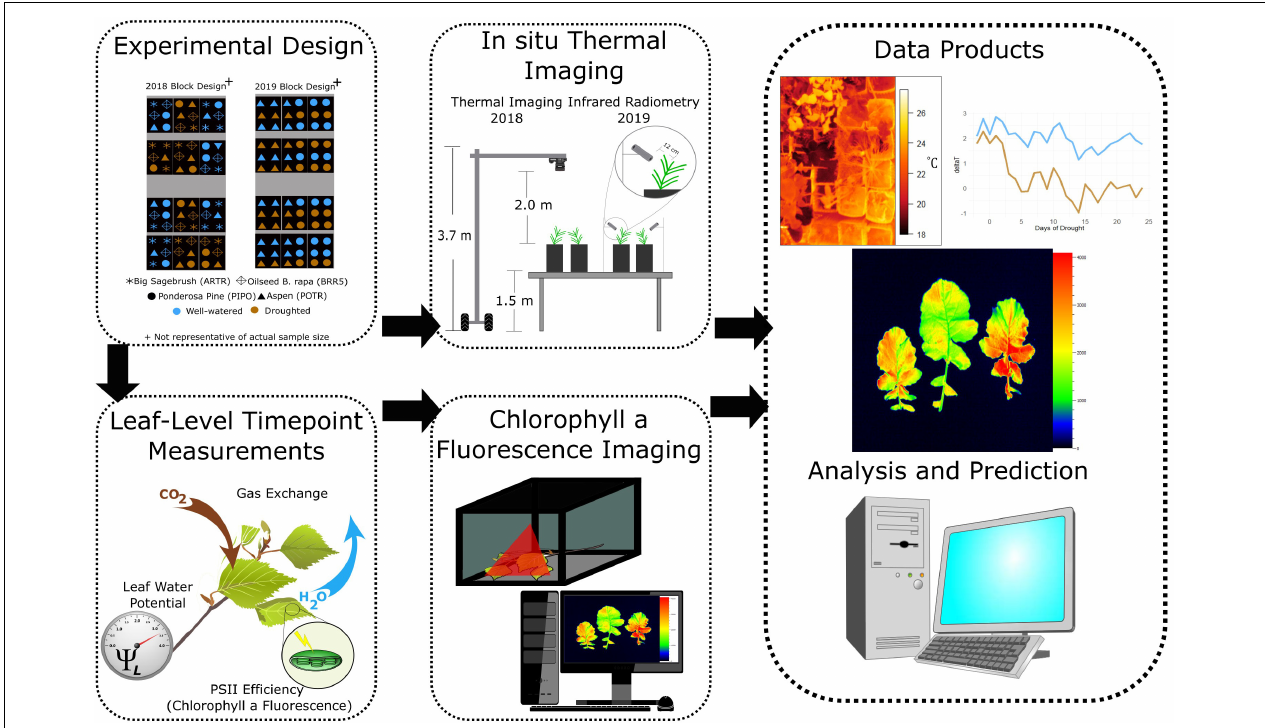
FIGURE 2 | Experimental design illustrating the integration of thermal, leaf-level measurements (ground truthing), and chlorophyll fluorescence images for severe (2018) and moderate (2019) drought scenarios.